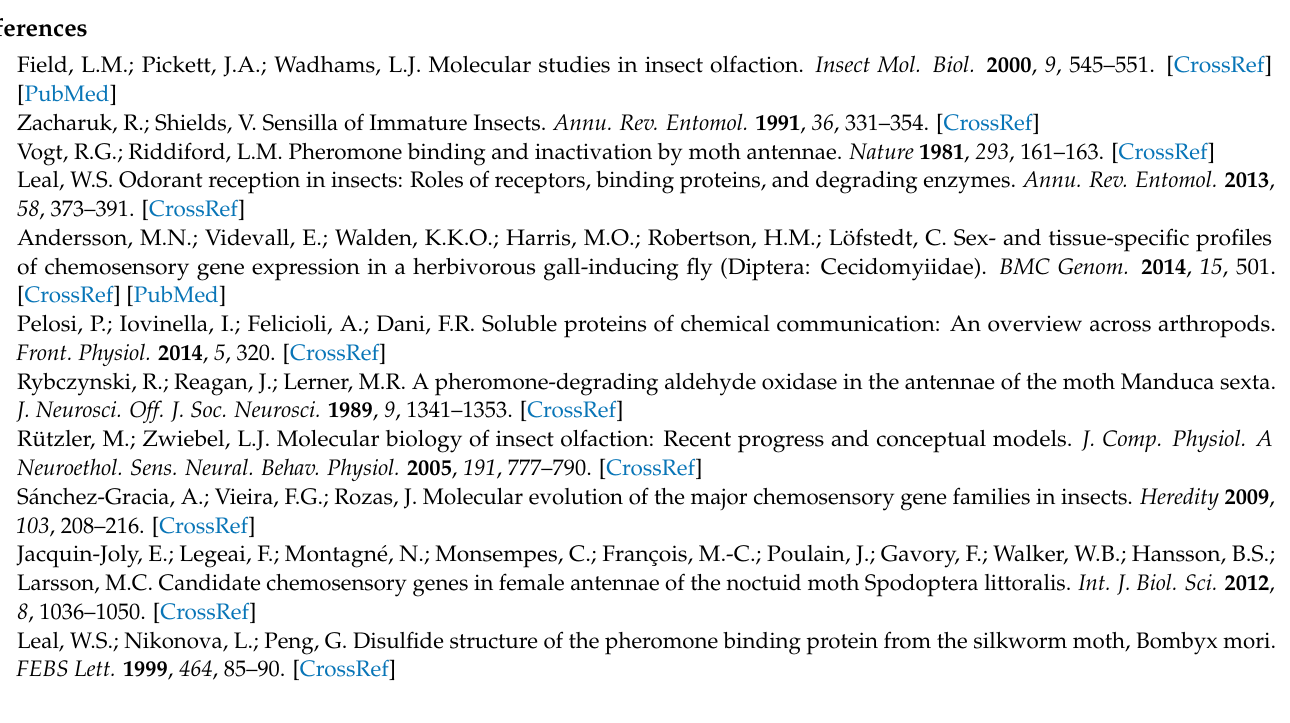
OBP genes. Table S3: The Blastx match of P. versicolora candidate GR, IR, OR and SNMP genes. File S1: The amino acid sequences of Plagiodera versicolora putative chemosensory receptor genes. File S2: The busco analysis of P. versicolora